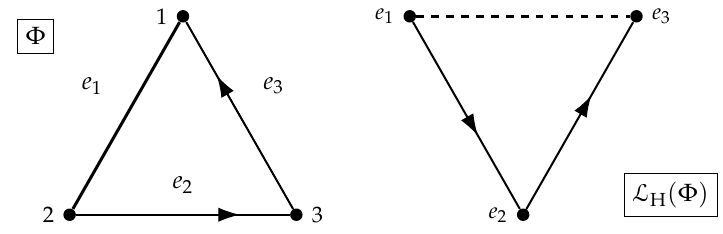
Figure 1. The unbalanced graph Φ = ( C 3 , ϕ ) and its balanced line graph L H ( Φ )